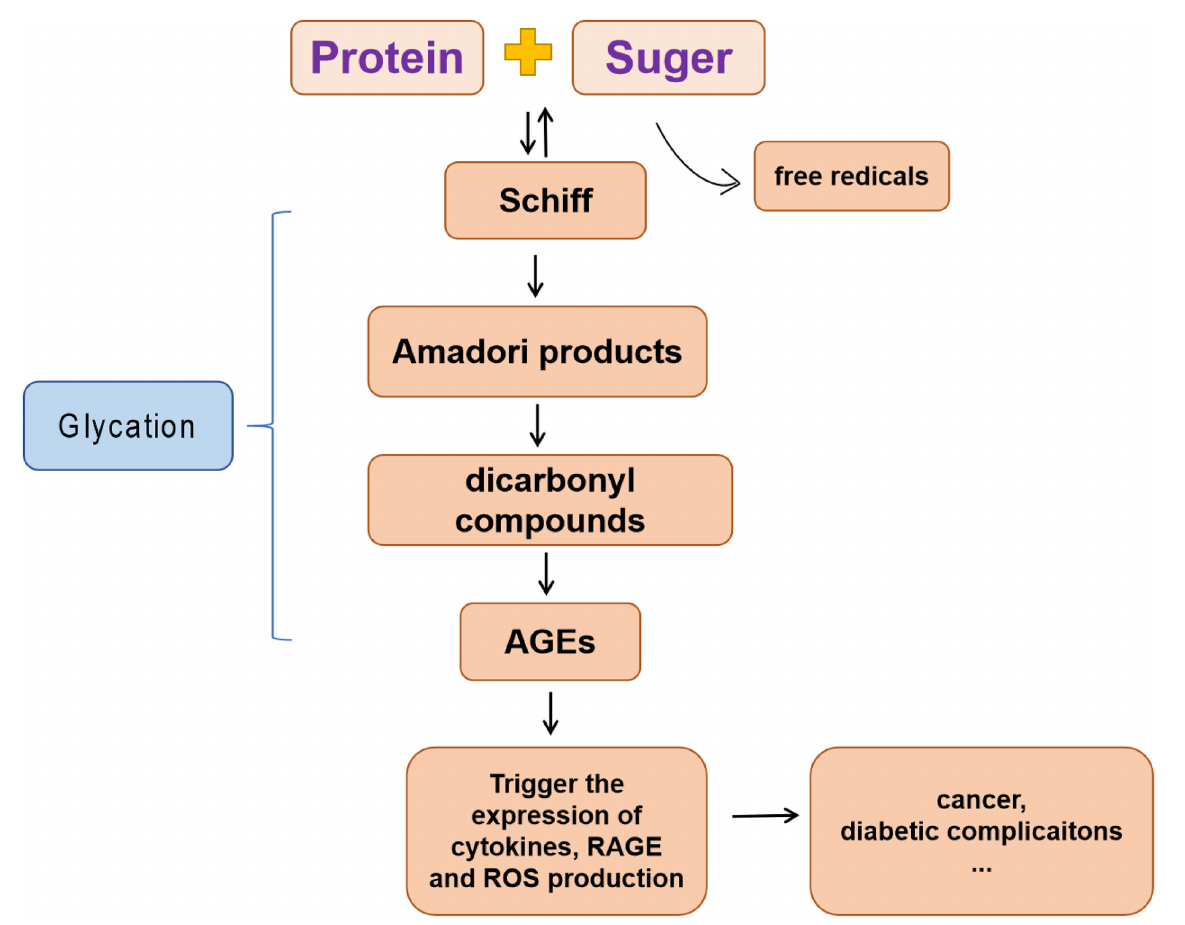
FIGURE1 The formation of advanced glycation end products (AGEs). A schematic representation of the formation of AGE and the interaction with the receptor for AGE (RAGE). Glycation includes three main levels and promotes various diseases, such as diabetic complications, cancer, and so on.